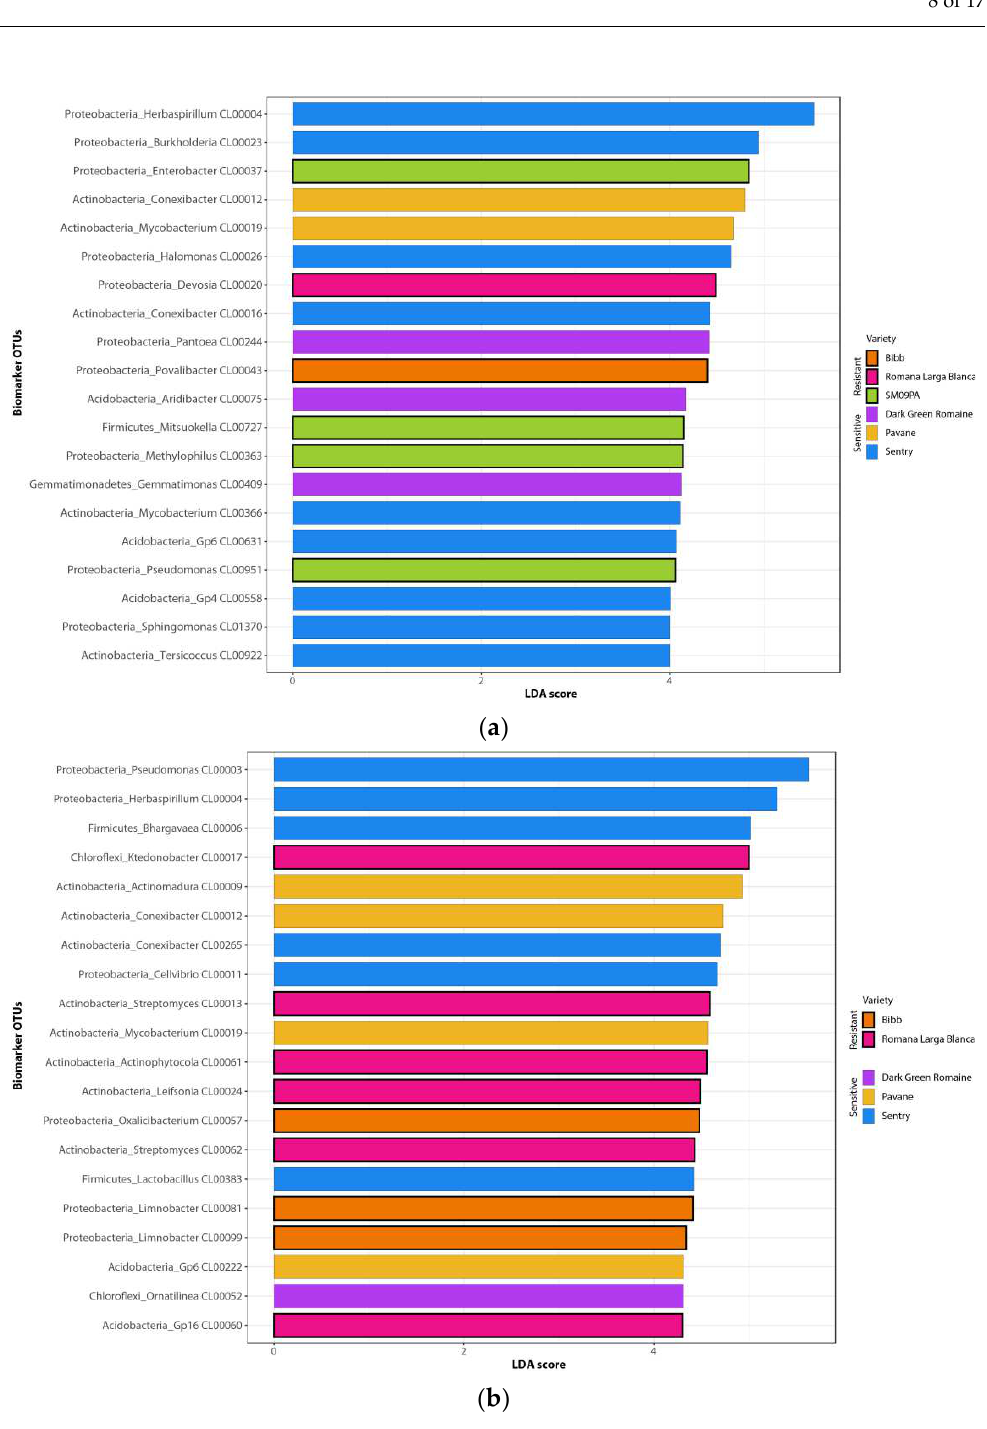
Figure 4. Bar charts of the first 20 LefSe biomarkers among bacterial OTUs in roots ( a ) and rhizosphere ( b ) of six lettuce varieties.